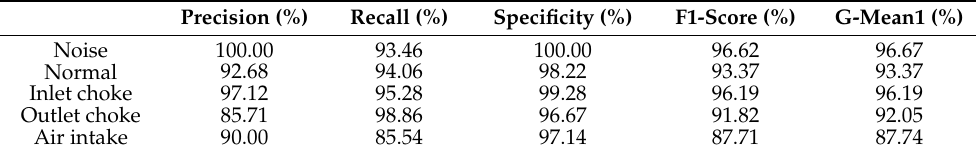
Table 3. The performance metrics of each class of the trained neural network